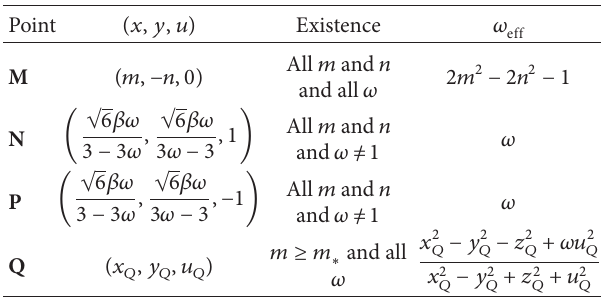
Table 1: Location and existence of critical points and corresponding effectiveequationofstateparameter. 𝑚 ∗ and( 𝑥 𝑄 , 𝑦 𝑄 , 𝑢 𝑄 )aredefined by (19) and (20),